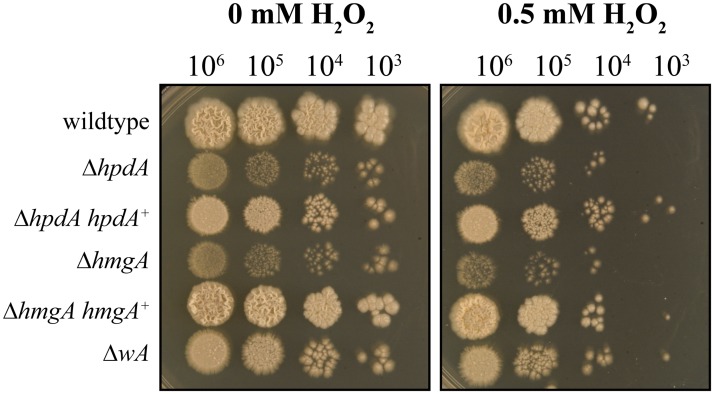
Pyomelanin is required for resistance to oxidative stress in P. marneffei.Serial dilutions of conidial suspensions of the wildtype, ΔhpdA, ΔhpdA hpdA
+, ΔhmgA, ΔhmgA hmgA
+ and ΔwA strains dropped onto medium containing tyrosine and 0 or 0.5 mM H2O2 and incubated for 6 days at 37°C.